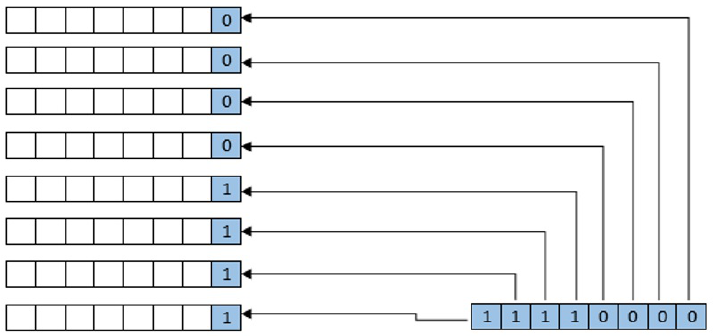
Figure 2. Embedding with message